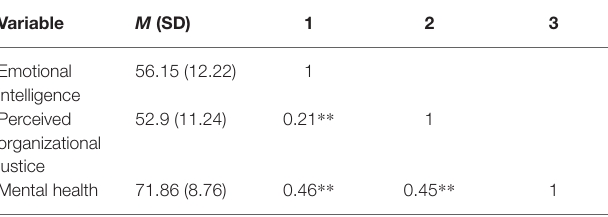
TABLE 2 | Descriptive statistics and correlations for all variables ( n =